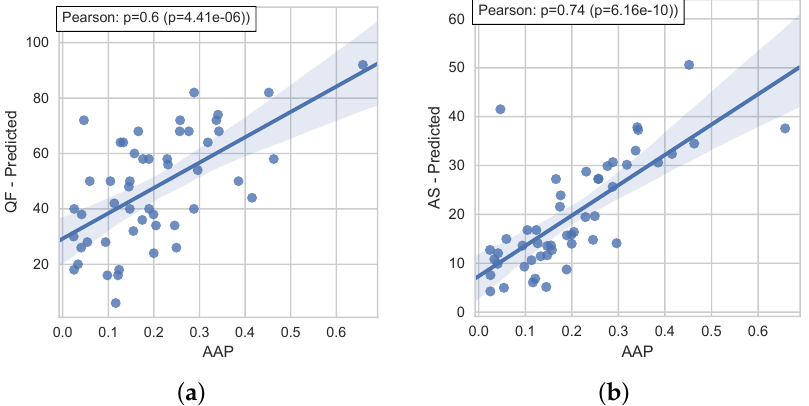
Figure 16. AS feature [83] is correlated to the average effectiveness of a set of systems. TREC7 Adhoc collection. Pearson correlation between AAP and ( a ) QF [66], ( b ) AS [83]. Dots correspond to actual and predicted AAP for individual topics; the cones represent the confidence intervals. Figure reprinted with permission from [82], Copyright 2018, Mizzaro et